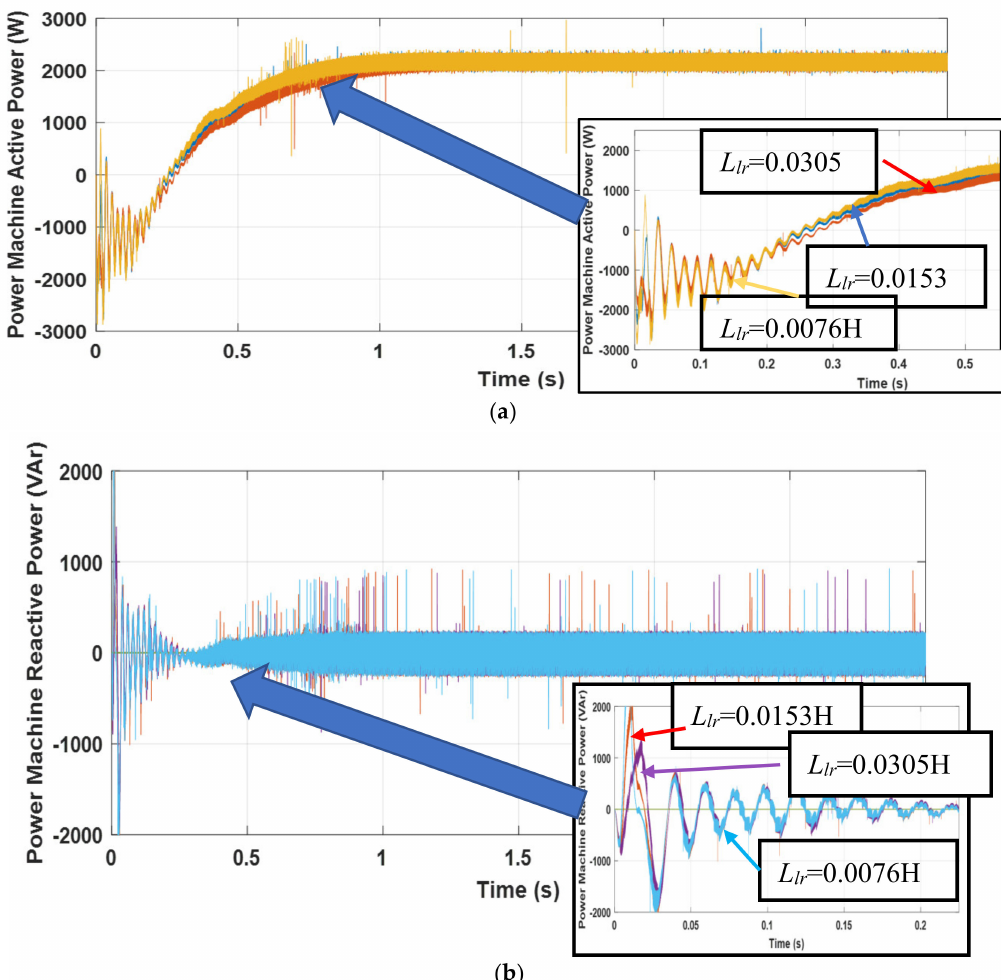
Figure A6. MSC waveforms at varing rotor leakage inductance: ( a ) grid injected power, ( b ) grid injected reactive